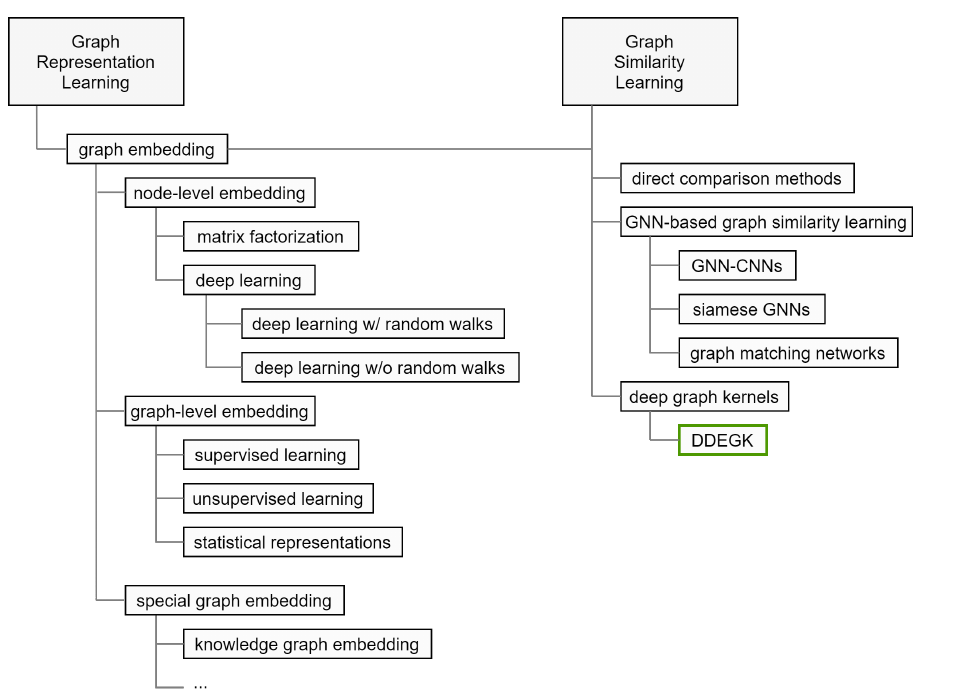
Figure 3. Proposed taxonomy for categorizing the literature on graph representation and similarity learning. The green box highlights the position of DDEGK.